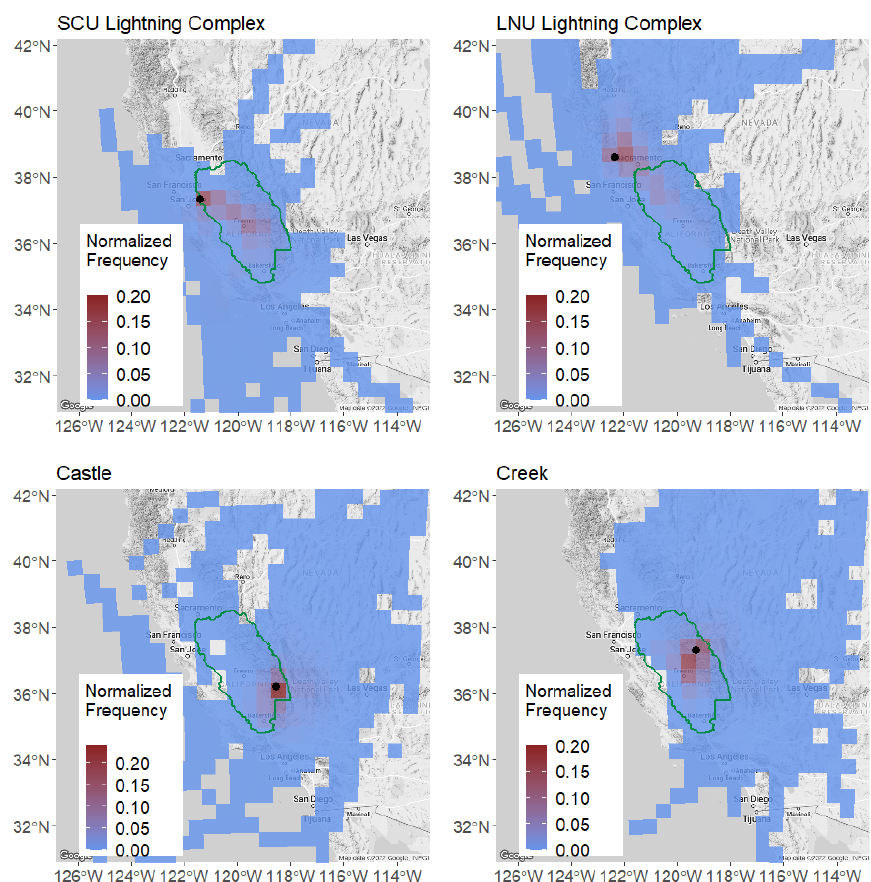
Figure 3. The frequency of trajectories starting from 50 m height at the location of four fires with the largest impact in the study area. The fire locations are shown with black dots. Table 1. Origin date, containment date, coordinates and size for fires considered in this study [40–43].